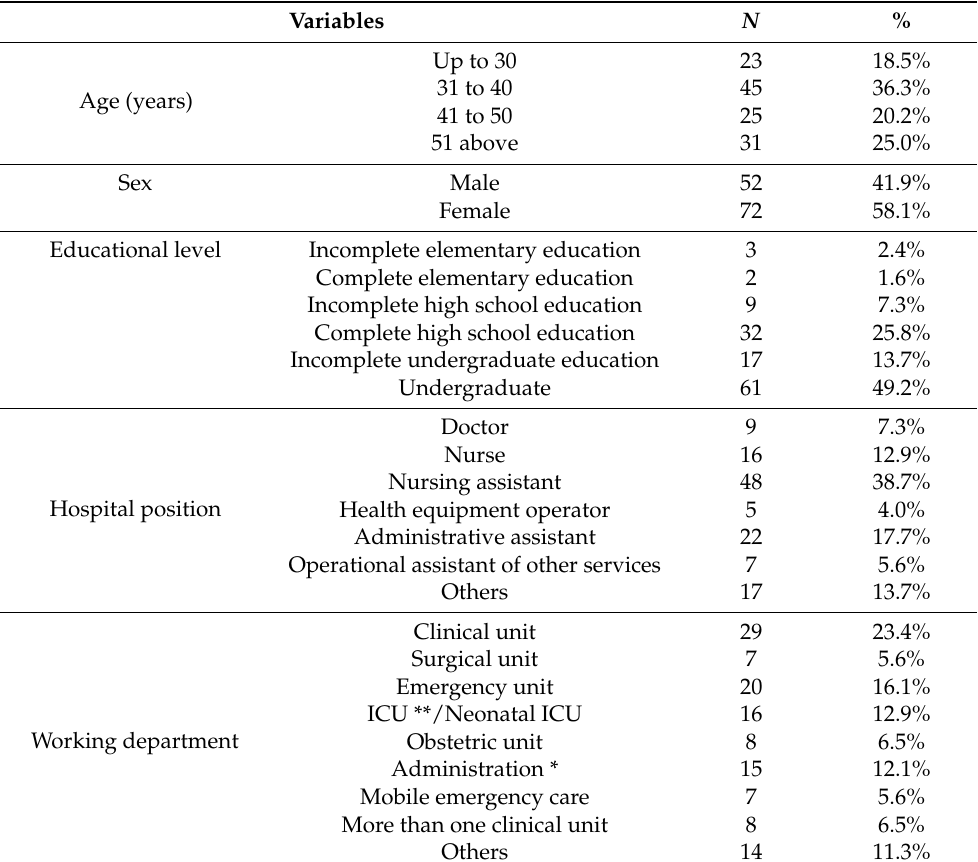
Table 1. Socio-demographic data of health professional users of public hospital restaurants (Federal District, Brazil).